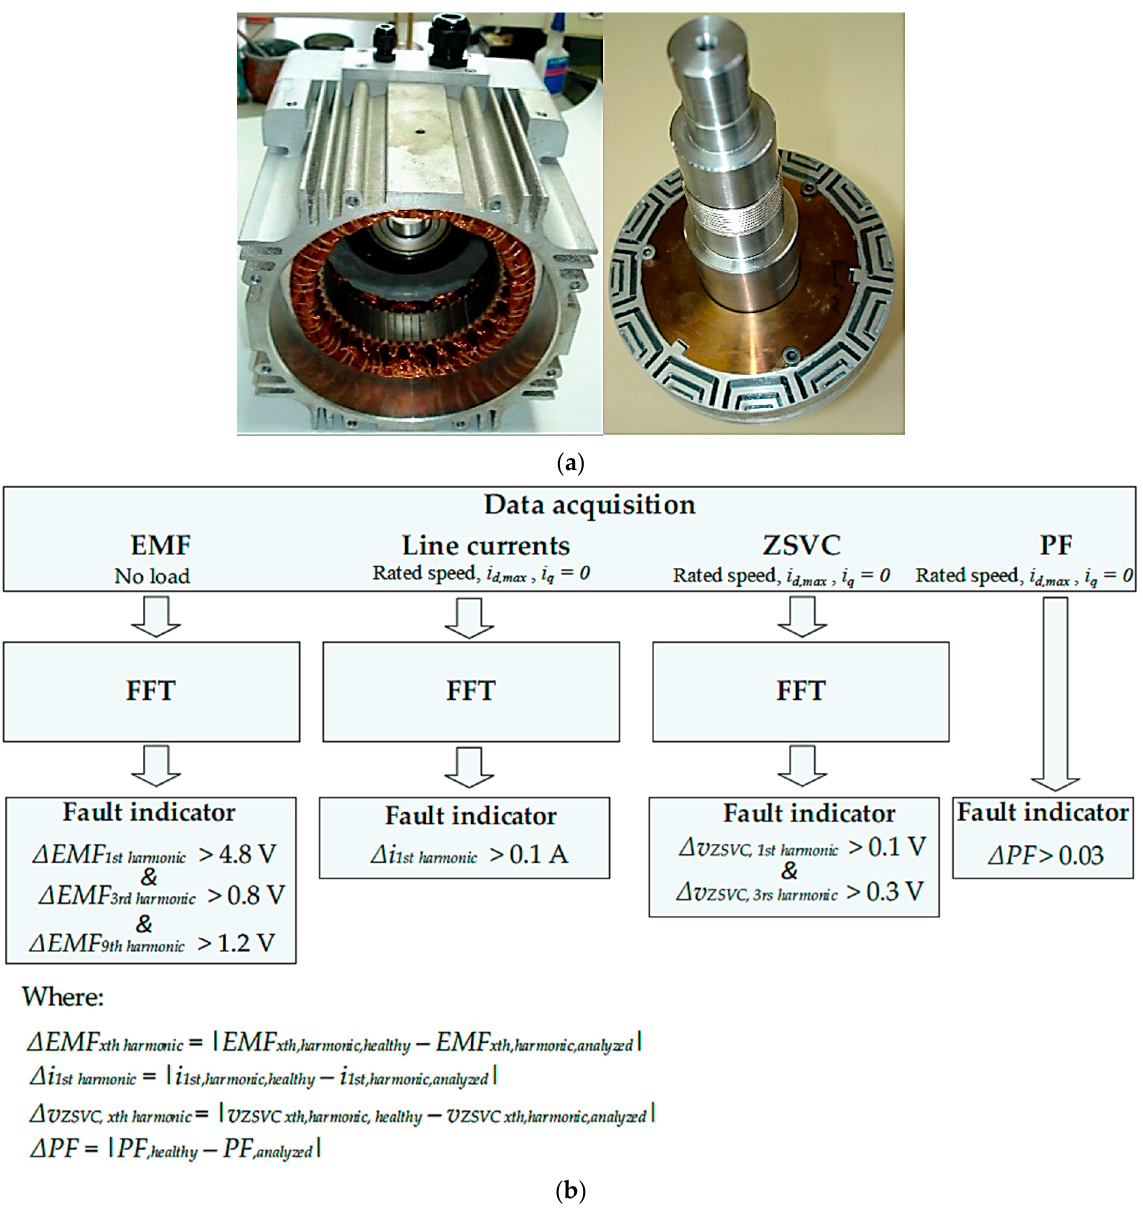
Figure 5. ( a ) The five-phase ferrite permanent magnet-assisted synchronous reluctance motor ana- lyzed in [13]. ( b ) Proposed fault indicators and partial demagnetization diagnosis strategy.